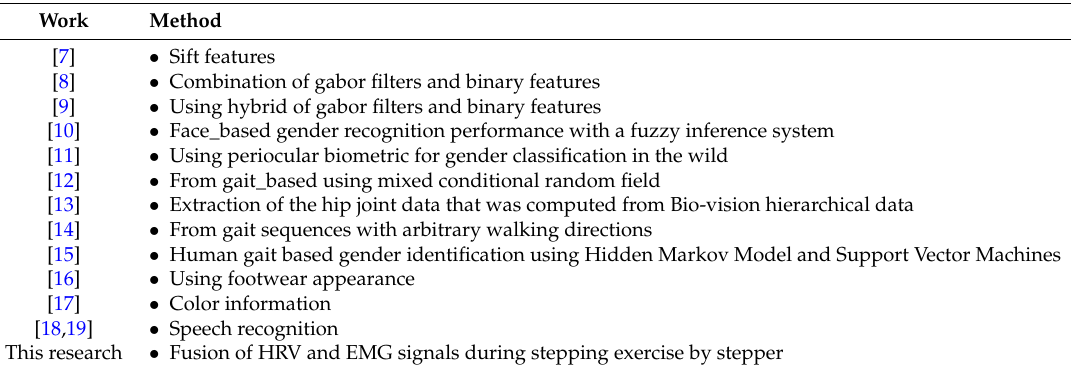
Table 1. Most related works for gender identification.